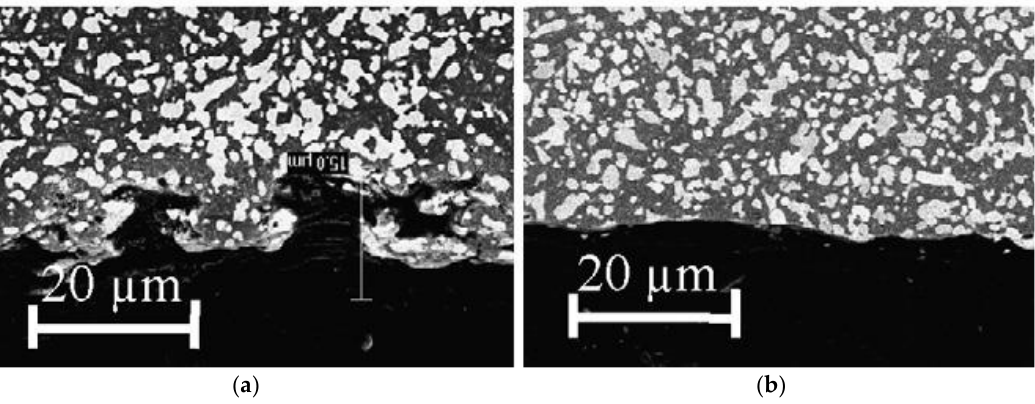
Figure 19. Cross-section views of samples machined by S-EDM: ( a ) relaxation pulse and ( b ) iso-energetic pulse. (Reproduced with permission from [140]).